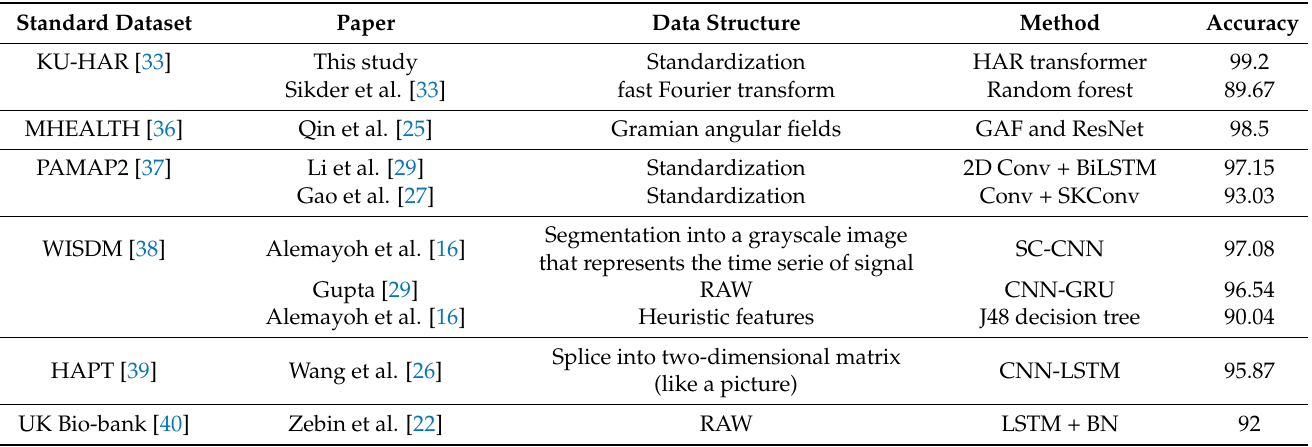
Table 1. Comparison of selected methods, preprocessing, and resulting accuracy over different datasets for HAR based on mobile sensors